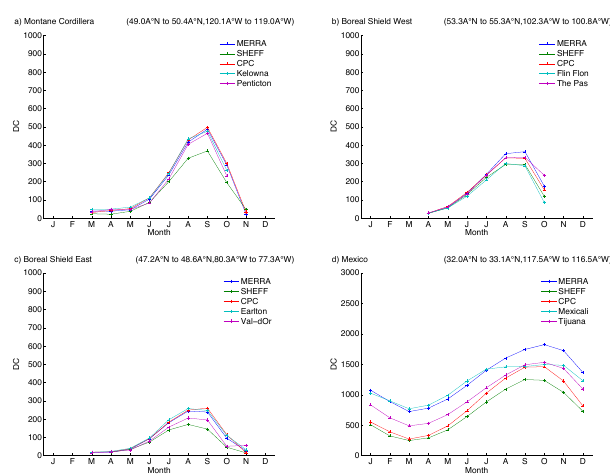
Figure 2. Monthly mean Drought Code (DC) for three regions in Canada and northwestern Mexico. MERRA, SHEFF and CPC DC are from the GFWED gridded fields over the latitude and longitude range specified in the caption. The other two DC plots are for repre- sentative weather stations in that range. Note the different DC scale for